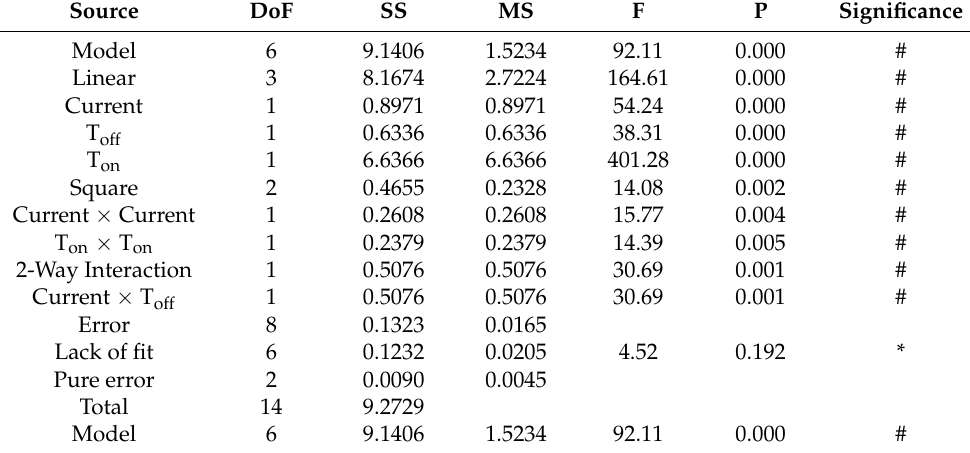
Table 5. ANOVA for